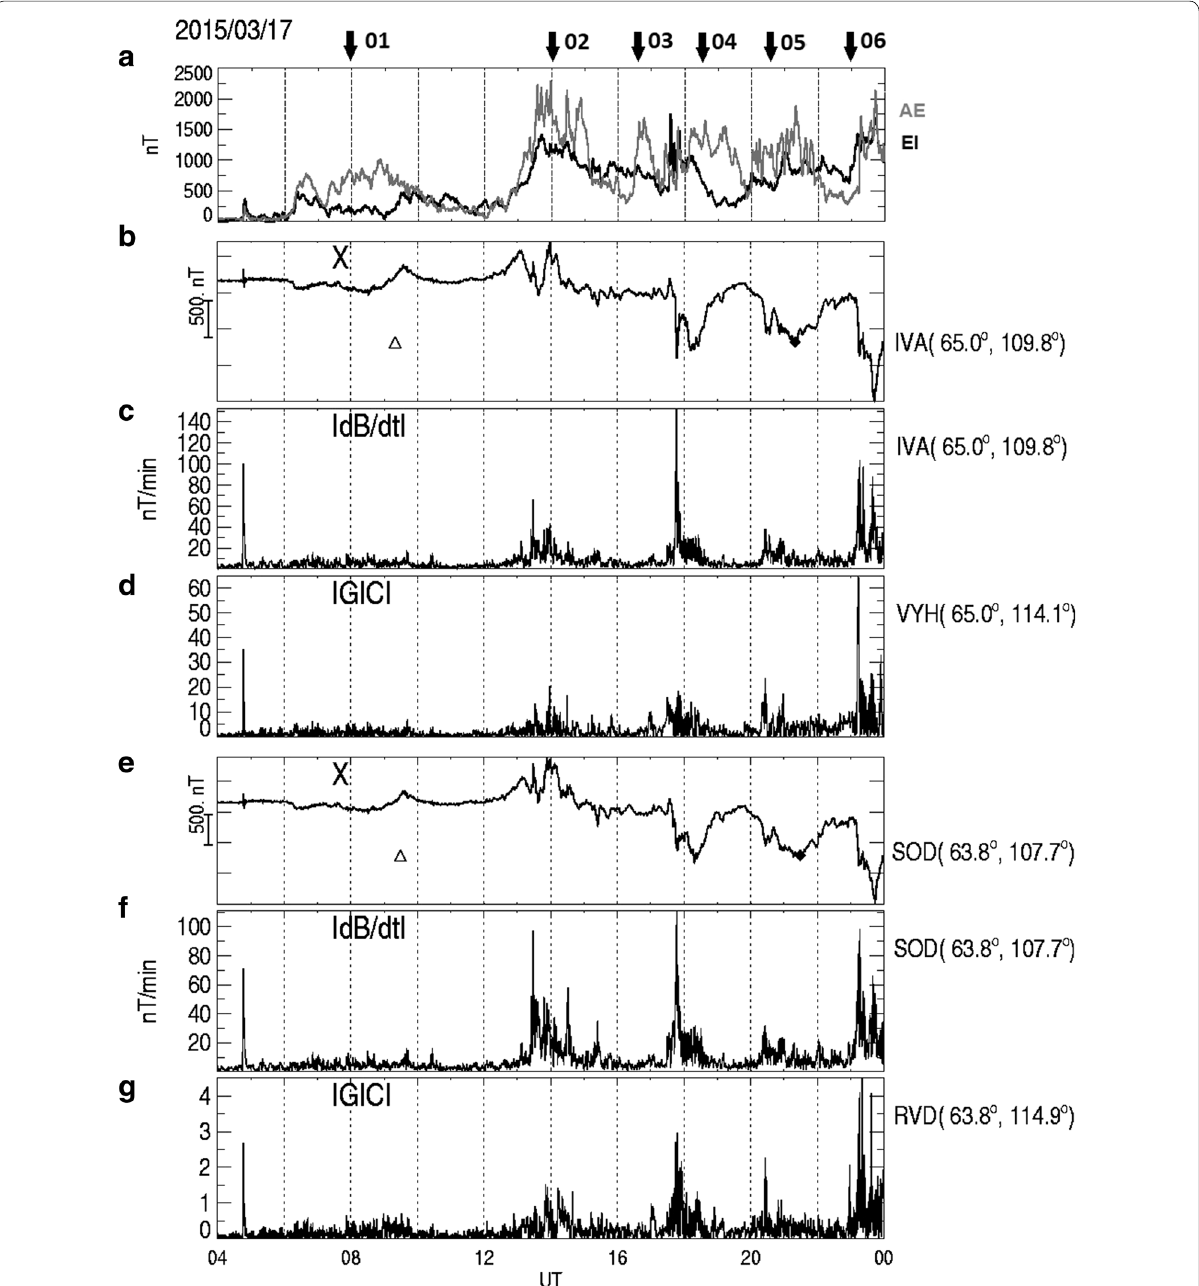
Fig. 8 Geomagnetic field variations and GICs in the power line system at stations VYH and RVD during March 17, 2015, 04–24 UT: a AE index (gray line) and local IMAGE EI-index (black line); b magnetic field Δ X variations at IVA; c variability of geomagnetic field |d B /d t | at IVA; d GIC magnitude at VYH; e magnetic field variations Δ X at SOD; f variability of geomagnetic field |d B /d t | at SOD; and g GIC magnitude at RVD. Arrows mark